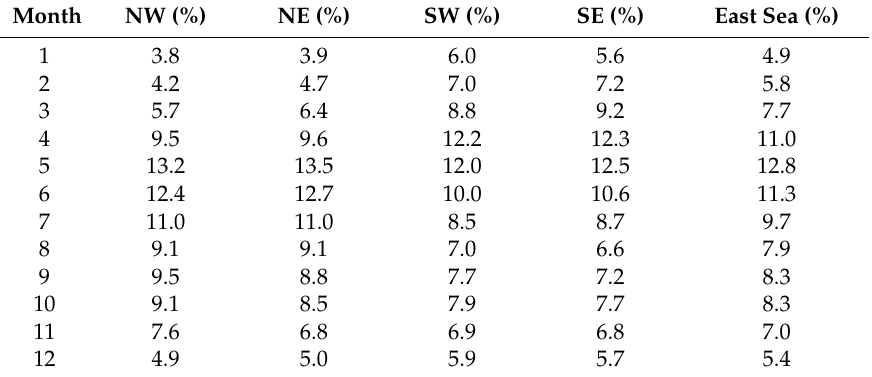
Table 1. The contribution of monthly primary productivity to the annual production for the four sub-research areas (NW, NE, SW, and SE) and the entire East